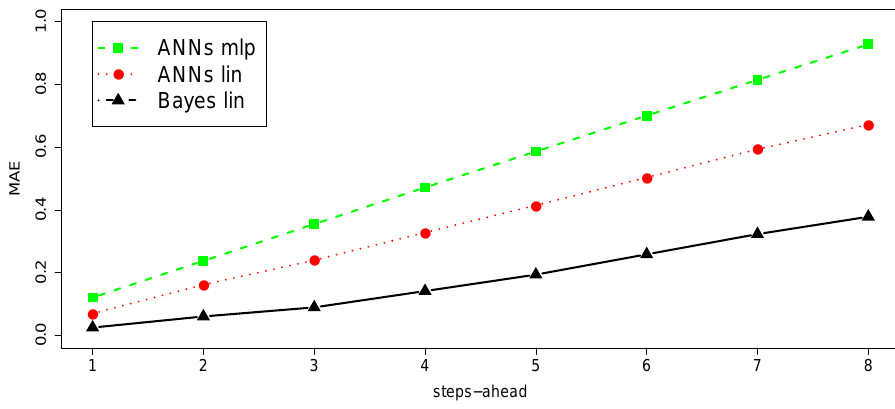
Figure 13. MAE of each step-ahead for SML house forecasts.